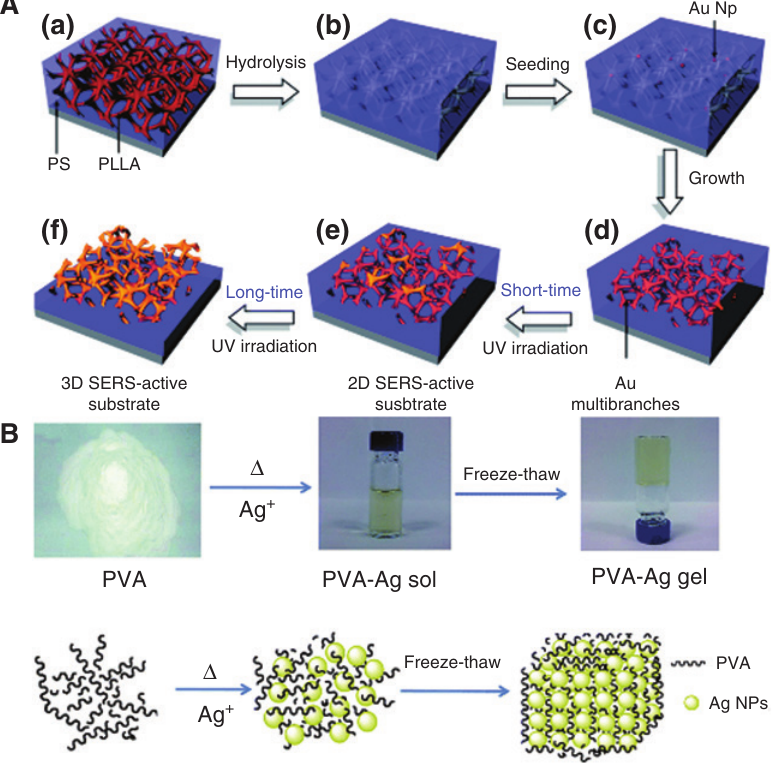
Figure 8: (A) Schematic illustration of the fabrication of a polymer-based substrate with protruded nanostructured Au from gyroid-struc- tured air networks. Adapted from Hsueh et al. J. Mater. Chem. C , 2014 , 2 , 4667–4675, with permission from the Royal Society of Chemistry. (B) Preparation procedure of PVA-Ag hydrogel 3D substrate by an in situ reduction strategy. Adapted from Ouyang et al. RSC Adv. , 2015 , 5 , 2231–2238, with permission from the Royal Society of